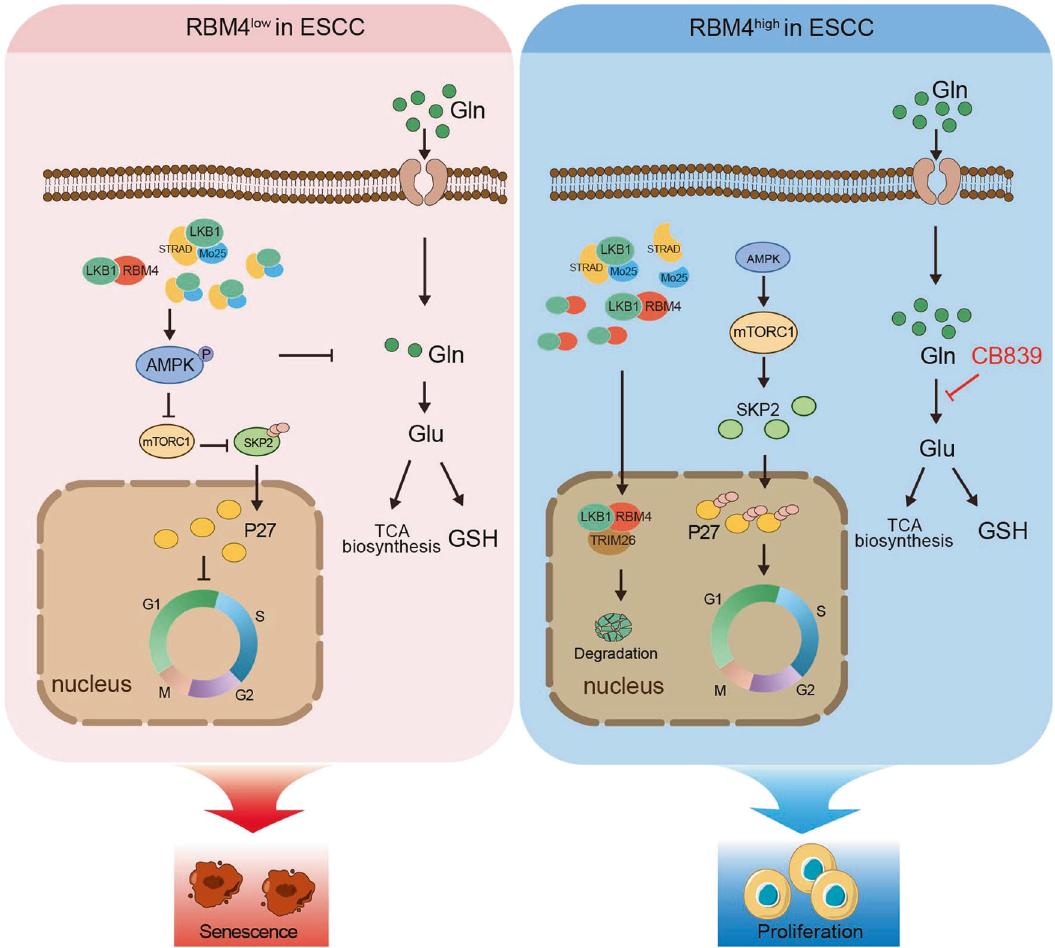
Fig. 8 Schematic of how RBM4 dictates ESCC cells fate from senescence to Glutamine-addiction survival through regulating LKB1-AMPK-P27 pathway. Mechanistically, RBM4 competitively bound to LKB1 to disrupt the formation of LKB1/STRAD/MO25 heterotrimeric complex and recruited the E3 ligase TRIM26 to LKB1, promoting the ubiquitination of LKB1 and its subsequent degradation, thereby conferring the enhanced sensitivity of glutaminase inhibitor CB-839 to RBM4-high ESCC. Conversely, RBM4 depletion stabilized LKB1 to activate p-AMPK, thus inhibiting mTOR activity and inducing P27-dependent senescence. The illustration of proliferative cells used elements from Servier Medical Art (https://smart.servier.com/) by Servier under a Creative Commons Attribution 3.0 Unported